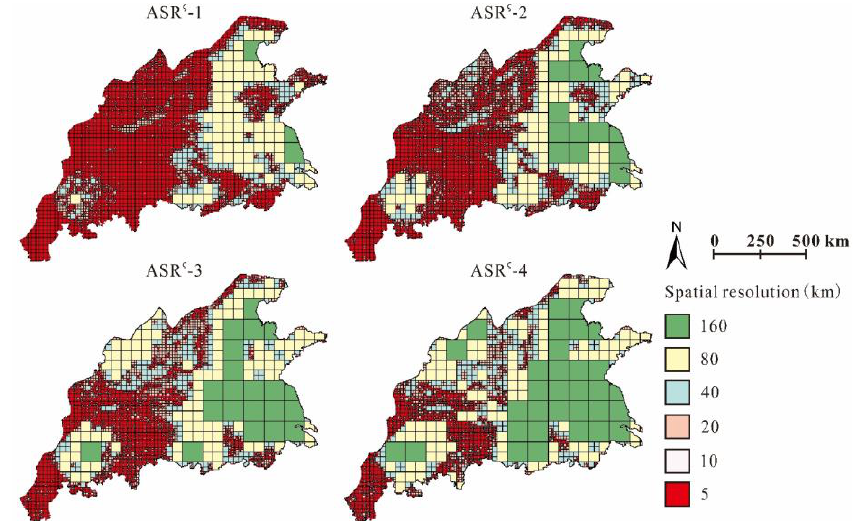
Figure 10. Appropriate spatial resolution of meteorological data for the regional potential productivity simulation determined based on the sill value ς of the DEM semi-variogram.